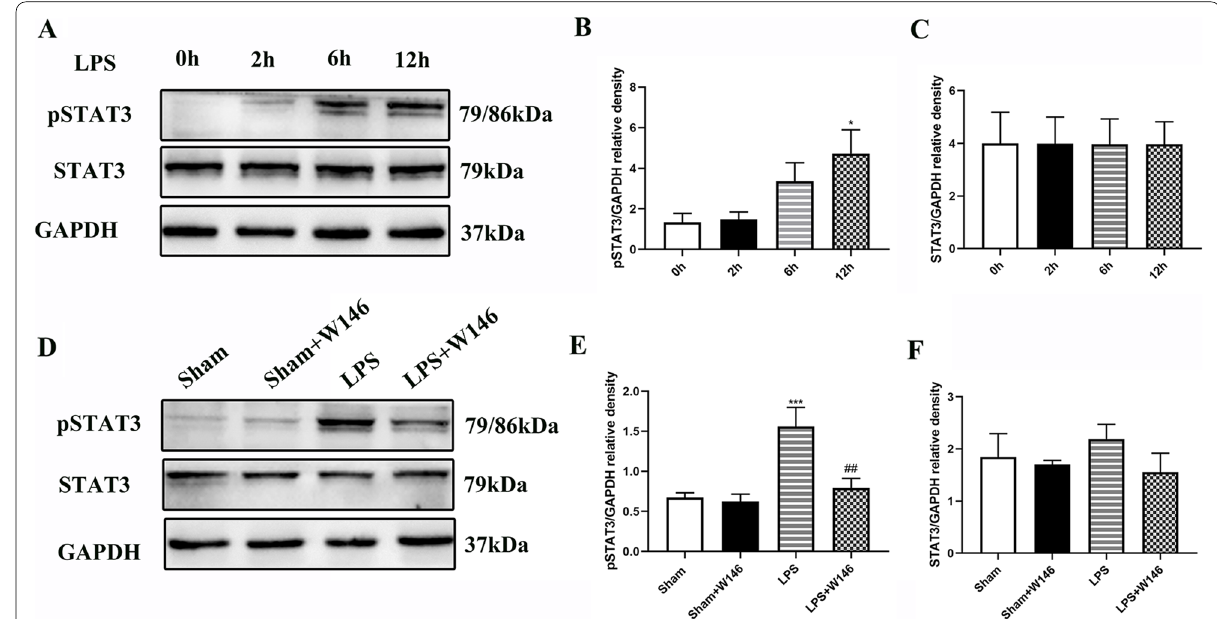
Fig. 5 Blocking S1PR1 attenuates LPS-induced increase of pSTAT3 in BV2 microglia in vitro . A‑C Representative western blots results showed that LPS induced an increase of pSTAT3 and this increase was time-dependent, most obvious after 12 h of LPS stimulation in BV2 cells (A, B) ; However, LPS did not change the expression of STAT3 (A, C); Data were presented as mean SEM of three independent experiments; * p < 0.05 compared ± with LPS 0 h. D‑F Pre-incubation of W146 before LPS stimulation could reduce the expression of pSTAT3, but had no effect on STAT3. Data were presented as mean SEM of three independent experiments; *** p < 0.001 vs. Sham group; # p < 0.05, ## p < 0.01 vs. LPS ±